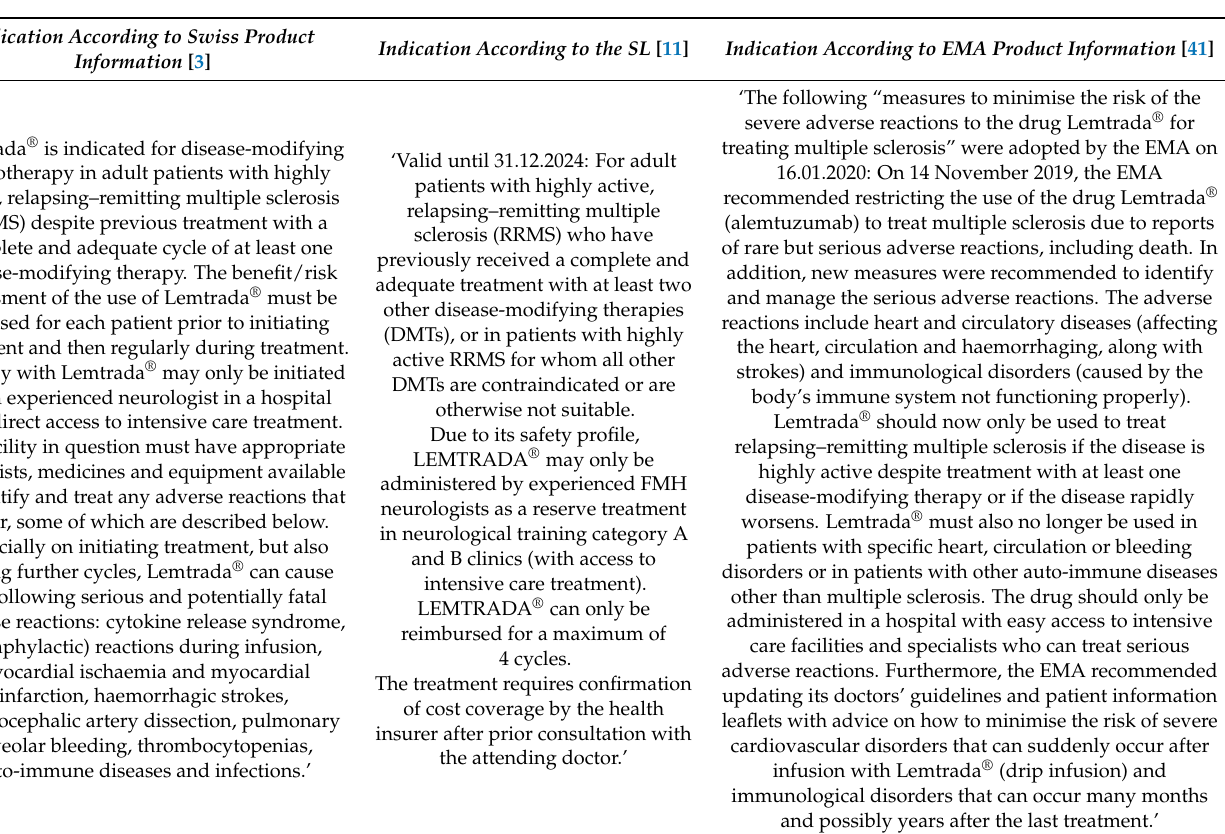
Table 8. Alemtuzumab (Lemtrada ®